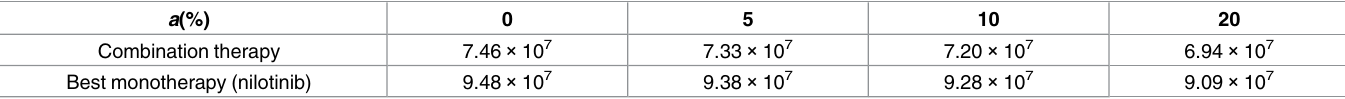
Table 10. The leukemic cell burden after a 36-month treatment for preexisting F317L assuming TKIs reduce the leukemic stem cell production rates. We assume that the TKIs reduce the productionrate of each leukemicstem cell by a %. a